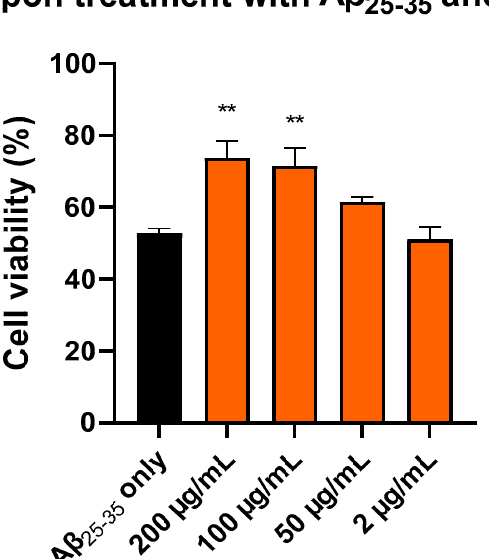
Figure 5. Determination of the neuroprotective capacity of various concentrations of SSW1 against amyloid-beta-induced toxicity in retinoic-acid-differentiated SH-SY5Y. Error bars show the SEM values of five independent experiments. Note: ** refers to p < 0.01 statistical significance compared with cells treated with 30 µ M A β 25–35 only (first column).